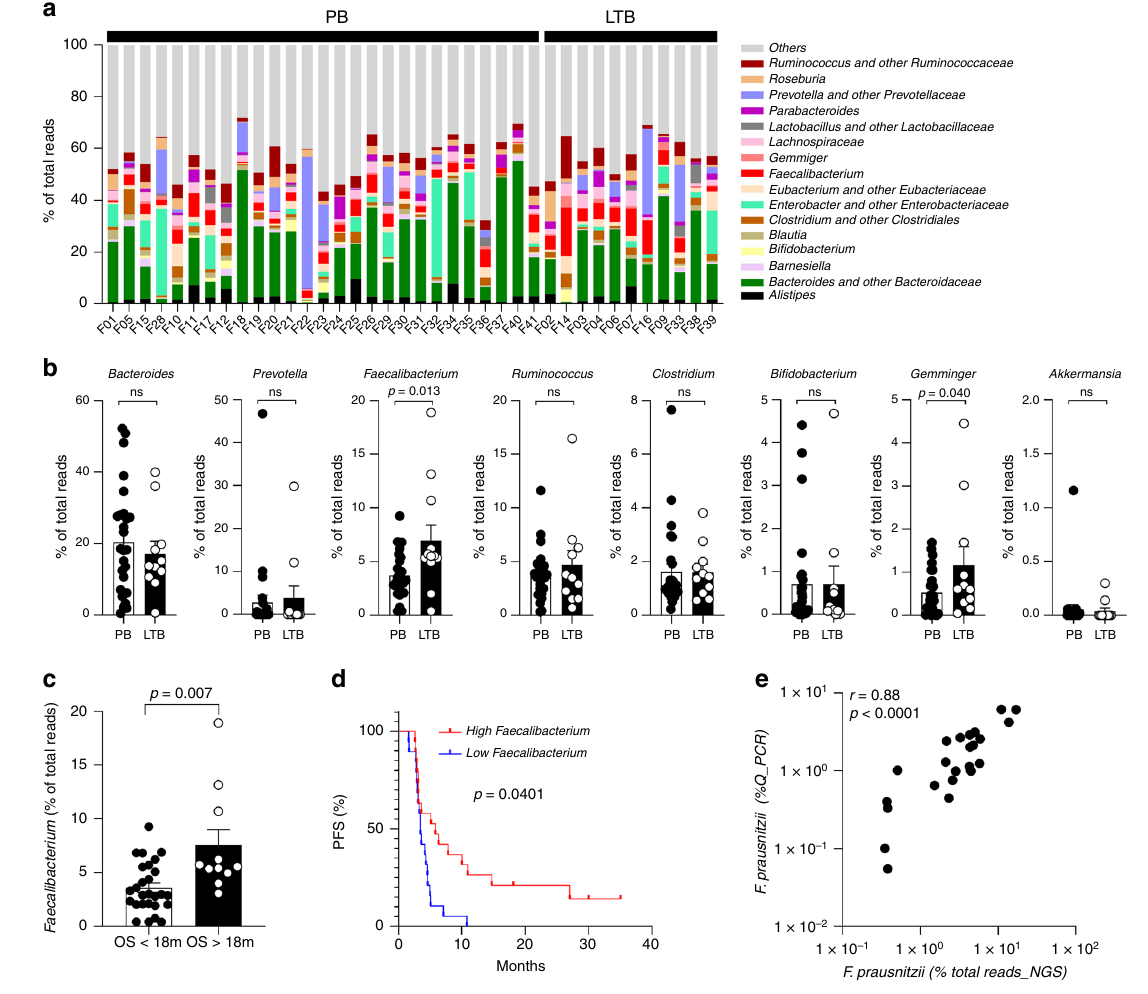
Fig. 1 Baseline gut microbiota composition in patients with MM. a Relative abundance of dominant (>1% of total reads) gut microbial genera are represented for each patient at V1 (baseline, n = 38). b Histograms of relative abundance of eight genera at baseline between poor (PB) and long-term clinical bene fi t (LTB) patients. Mann – Whitney two-tailed tests were used. p -values are indicated on each graph. c Histograms of relative abundance of Faecalibacterium according to overall survival (OS over 18 months (OS > 18 m) and OS under 18 months (OS < 18 m)) in patients. Mann – Whitney two-tailed tests were used. p- values are indicated on the graph. d , Kaplan – Meier curve of progression-free survival (PFS) of patients classi fi ed into two groups according to the median relative abundance of Faecalibacterium ( n = 38). Log-rank (mantel-cox) test was used. e Pearson correlation between the relative abundance of Faecalibacterium assessed by 16S rDNA analysis (% of total reads NGS) and Q-PCR (% Q-PCR) analyses on feces at baseline ( n = 24). r and p values are indicated on each graph. ns, not signi propionate was associated with longer PFS in the pooled cohort (Supplementary Fig. 10e, p = 0.0015 and p = 0.0029 respectively).